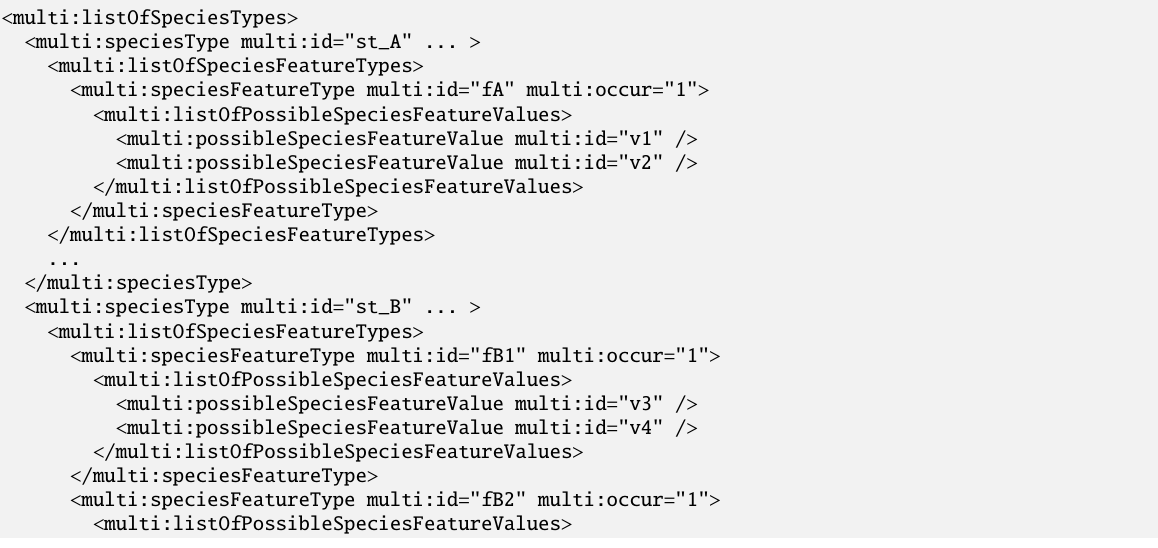
The SBML code for the speciesType s “ st_A ”, “ st_B ”, and “ st_X ”, and the species “ sp_X3 ” can be as